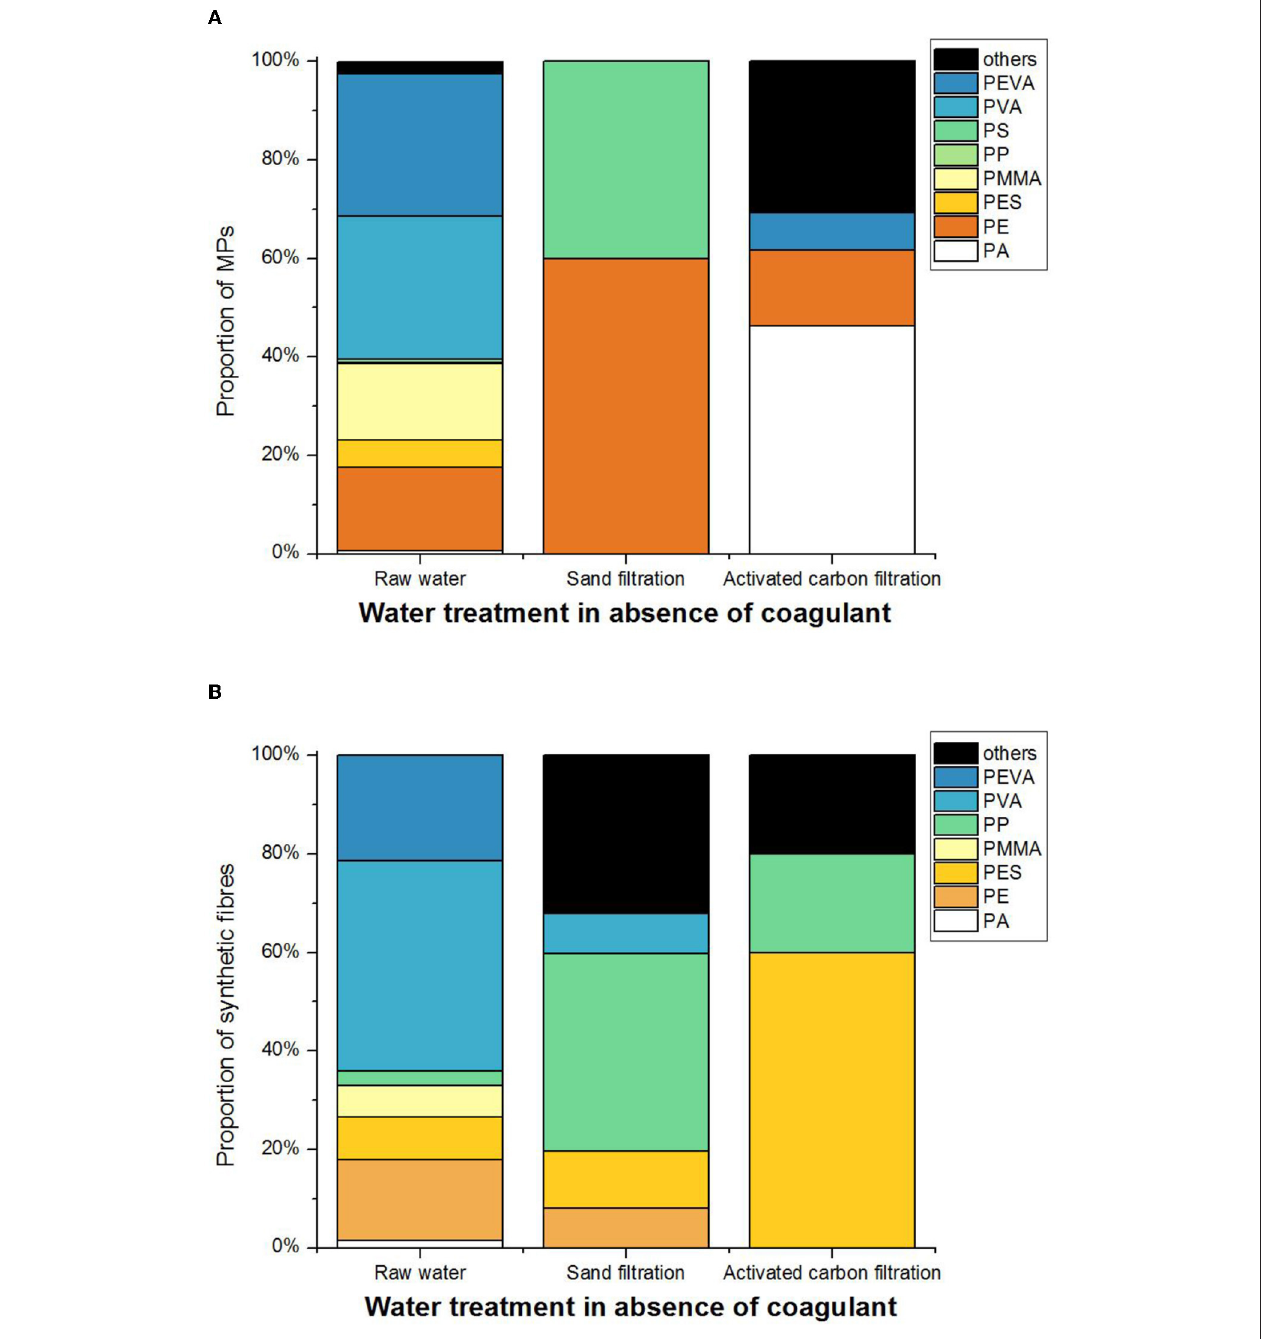
FIGURE 7 | Chemical composition of MPs (A) and synthetic fibres (B) in raw water, after sand filtration and after activated carbon filtration in absence of coagulant.